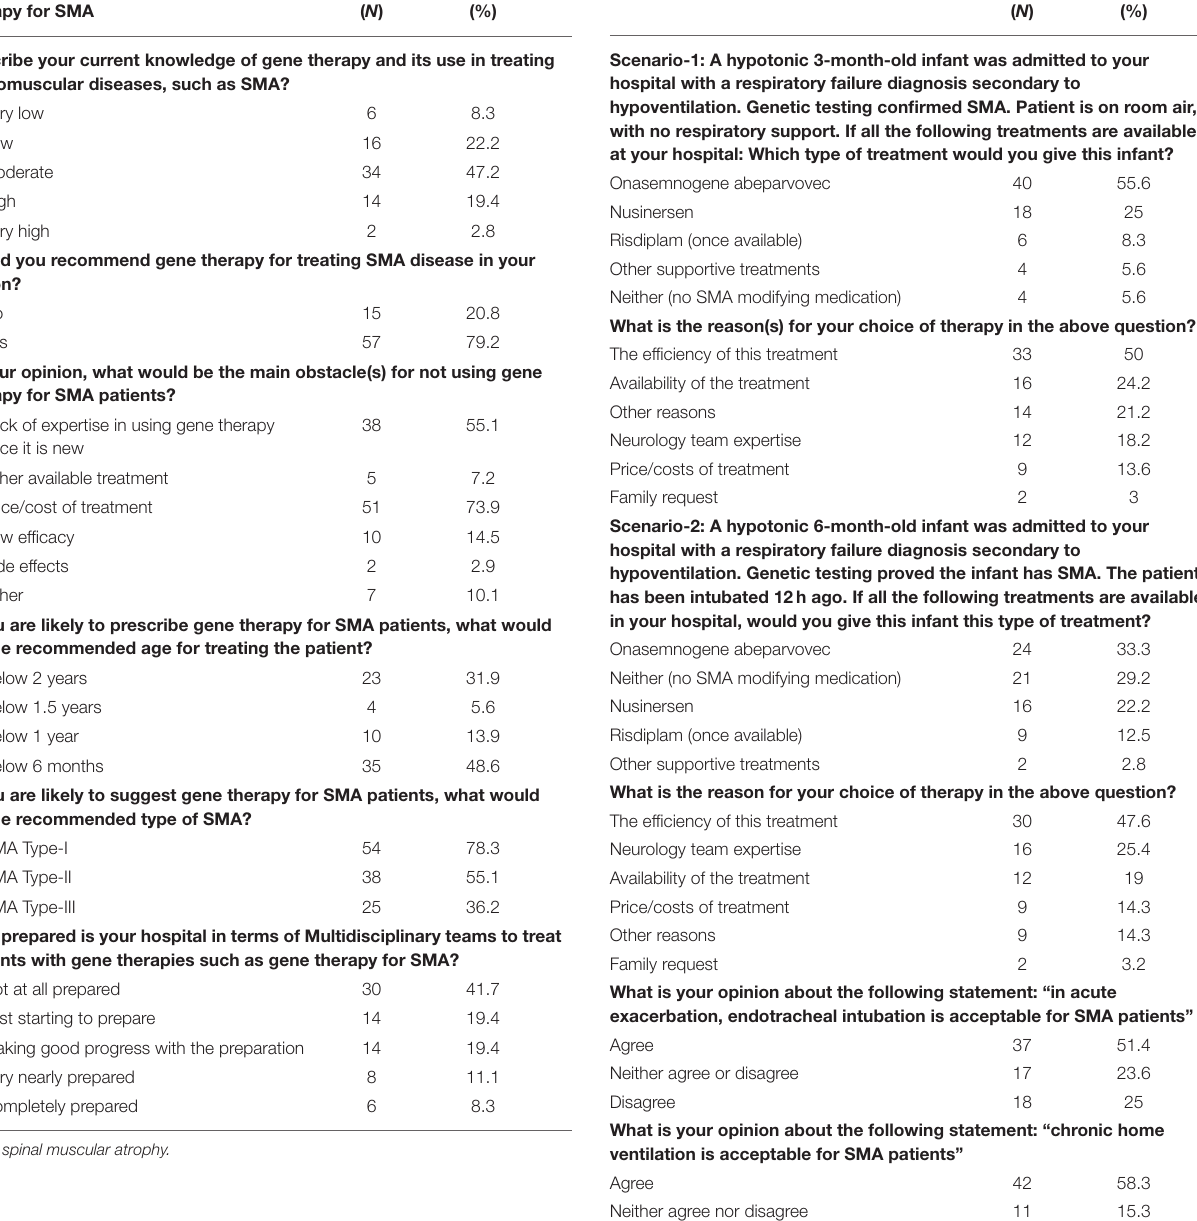
TABLE 4 | Responses of the respondents toward the two case scenarios. Responses toward the two case scenarios Frequency